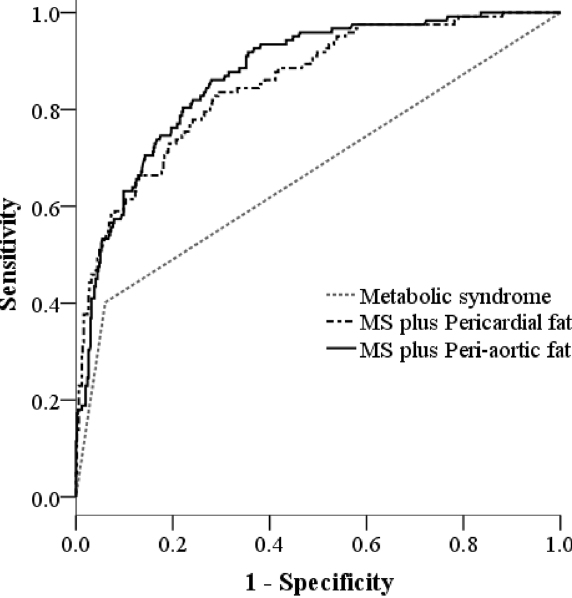
Figure 2. ROC curve analysis for metabolic syndrome, pericardial fat and thoracic peri-arotic fat in discriminating fatty liver